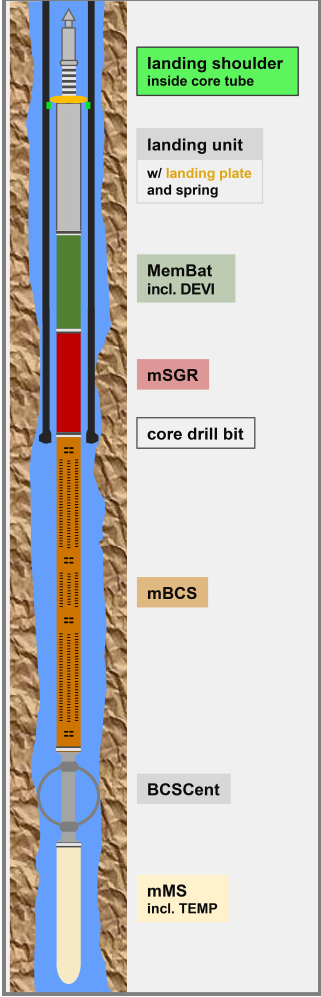
Figure 2. Sketch of a standard ICDP memory-logging system (iMLS) tool combination landed at the bottom of the drill string, partially sticking out into the open hole in a ready-to-log position (not to